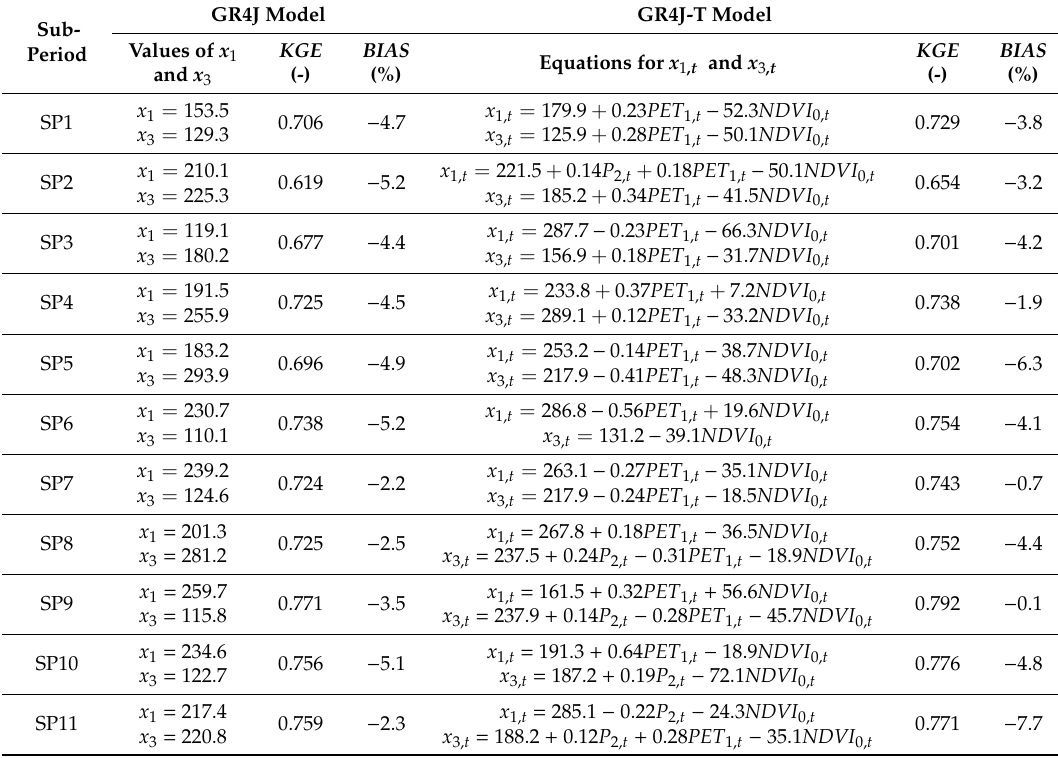
Table 6. Comparison of streamflow simulation performance of the GR4J model and the GR4J-Model in Tuojiang Basin for all sub-periods